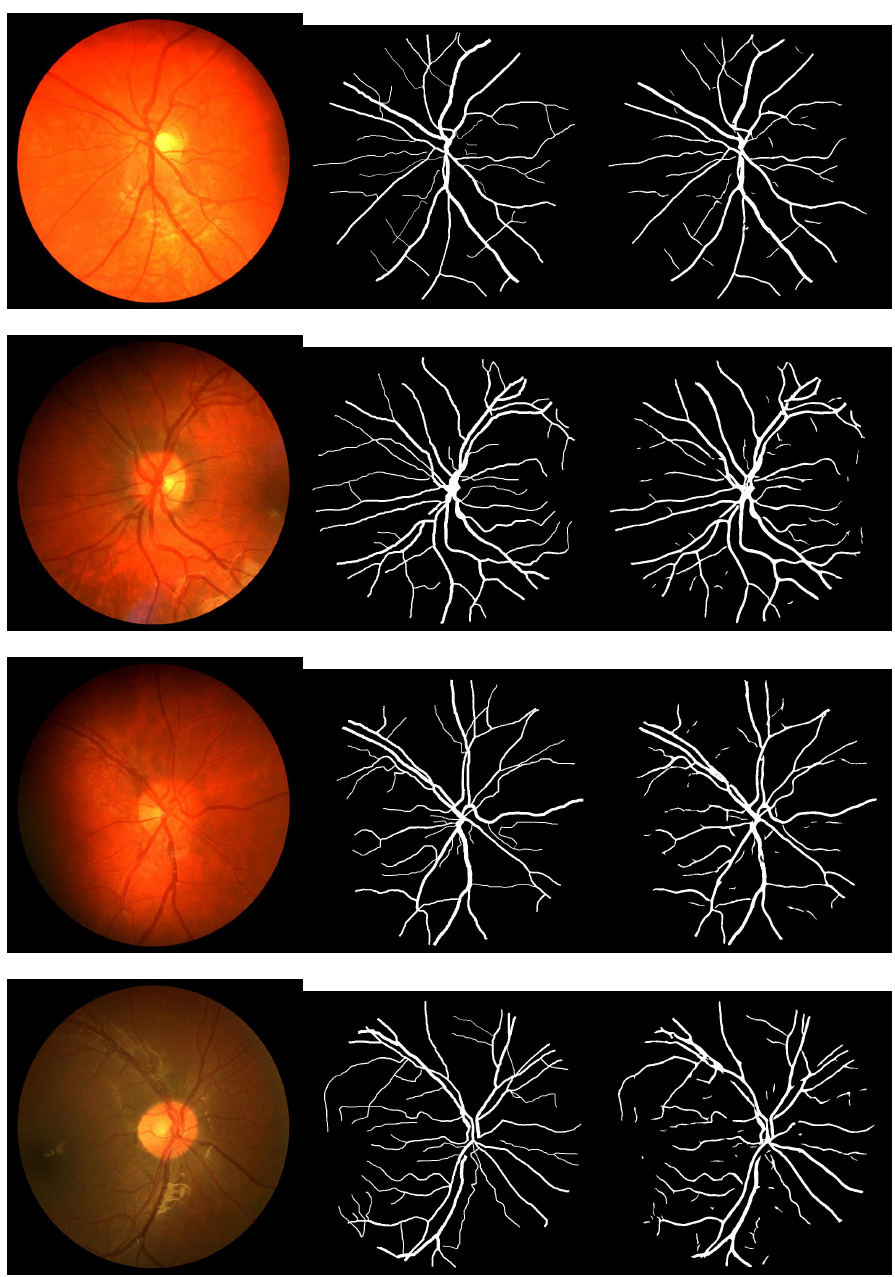
Figure 2. Sample images, their corresponding ground truth and the outcome of the proposed network while testing the CHASE_DB1 dataset (left to